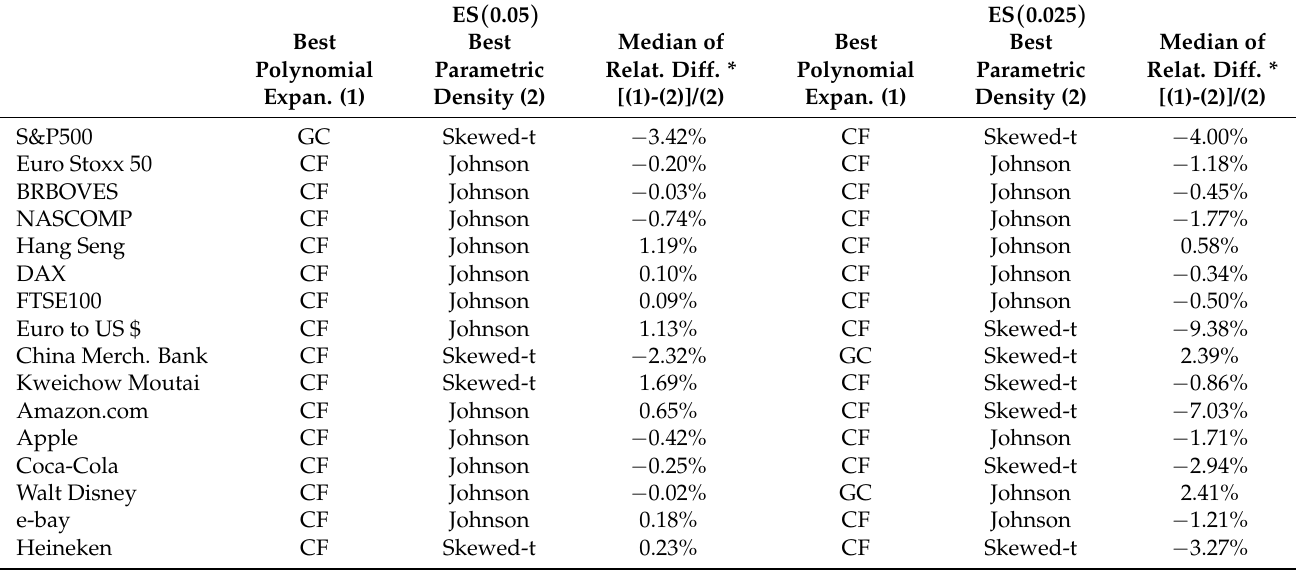
Table 6. Comparison of Distributions with Loss Functions: